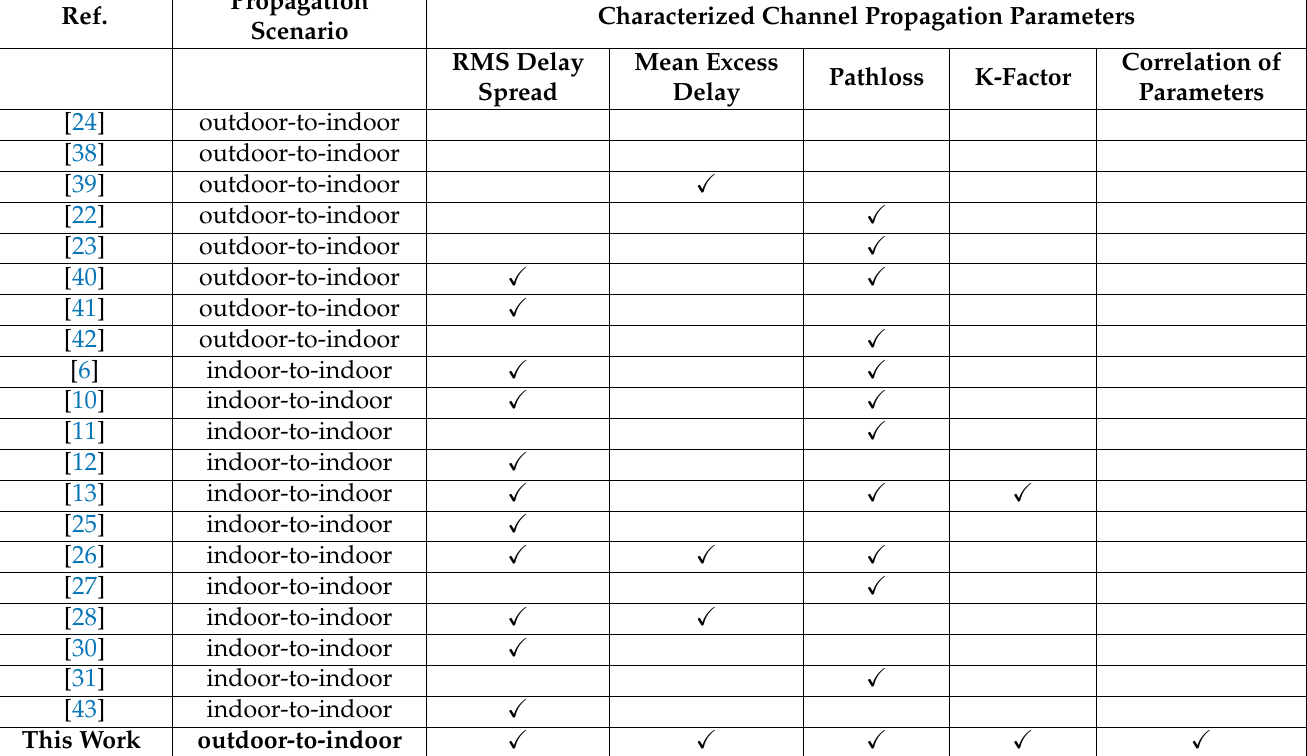
Table 1. Comparison between the proposed work and existing literature analyzed in Section 2.3. Note that works in [24,38] do not address specific analyses of propagation parameters. However, we report them in the table for completeness, since they discuss relevant aspects related to outdoor-to-indoor propagation (e.g., building penetration and channel matrix